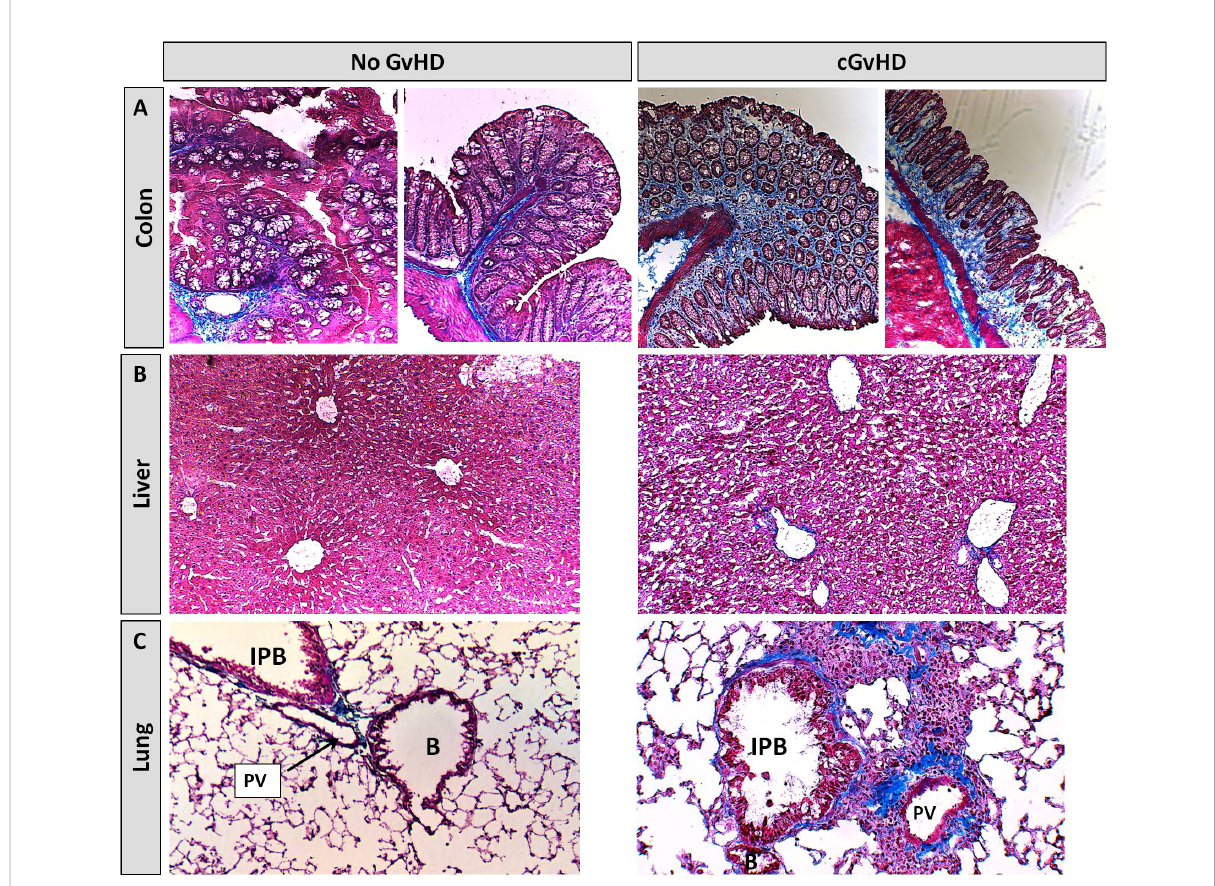
FIGURE 14 Histological characterization of xeno-cGvHD at day+125 after xeno-HCT. Masson ’ s trichrome fi brosis staining in cGvHD target organs (A) colon, (B) liver and (C) lung of xeno-transplanted and only irradiated, but not-transplanted NSG-recipients. Blue, collagen fi bres ( fi brosis); red, cytoplasm; keratin, muscle fi bers and erythrocytes, dark red/black, nuclei; in fi ltrating immune cells. 20x magni fi cation. PV, Pulmonary vein; IPB, Intrapulmonary bronchus; B,